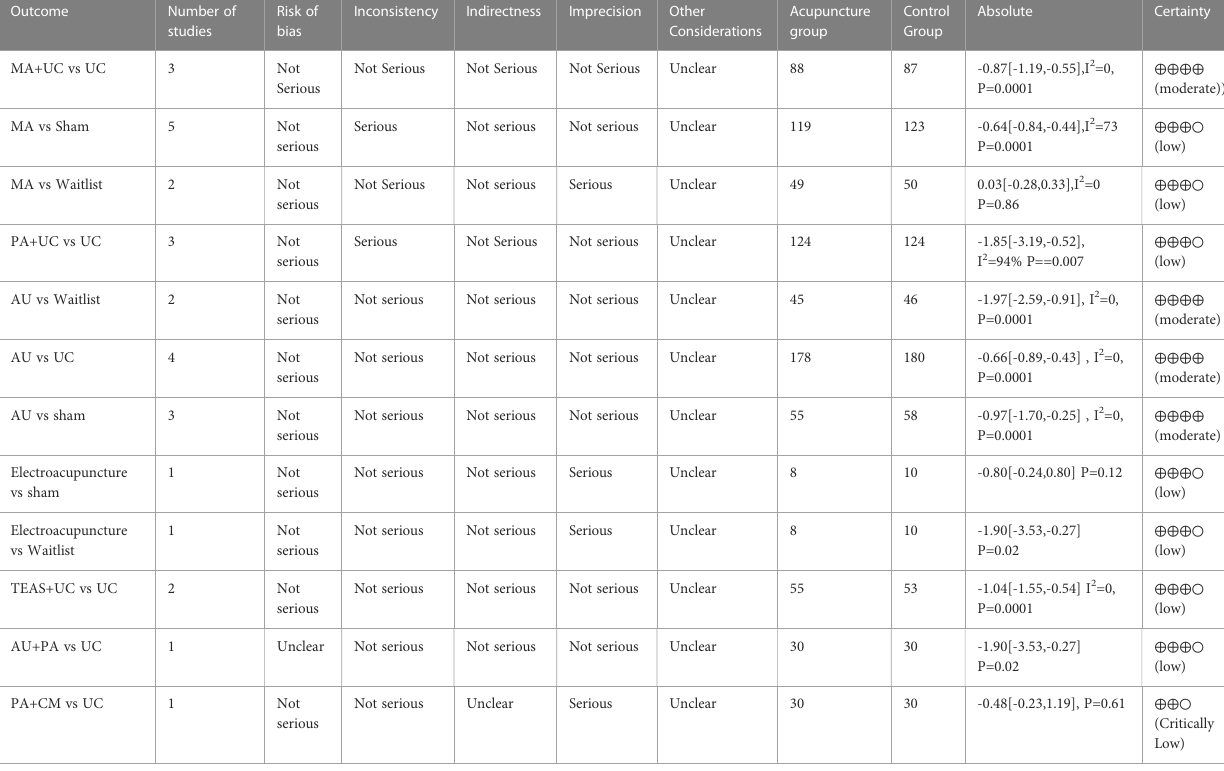
TABLE 6 Quality of evidence of CFS in network